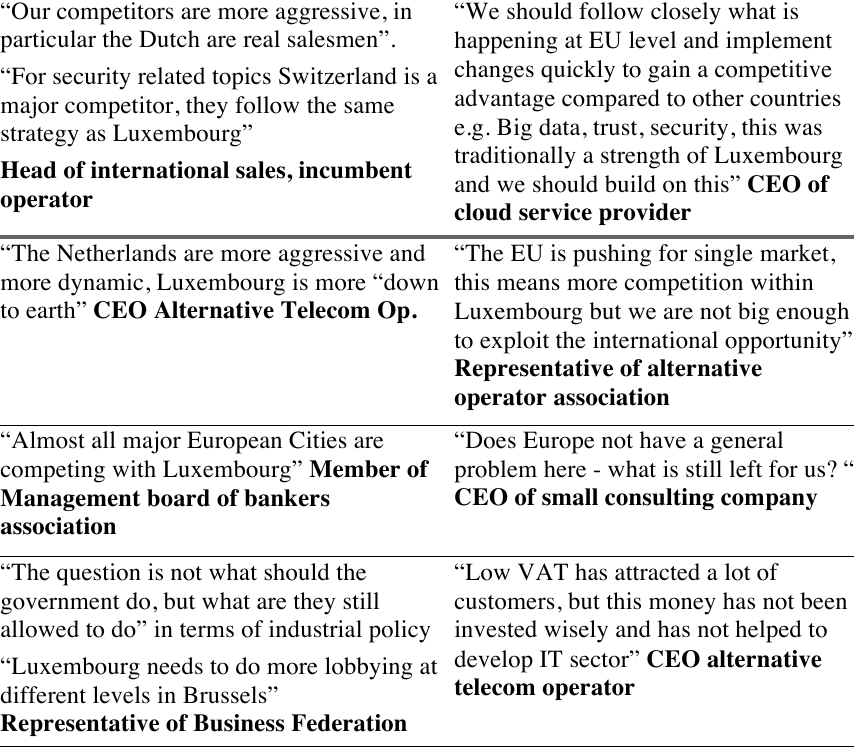
Table 2. Examples of exogenous factors “Our competitors are more aggressive, in particular the Dutch are real